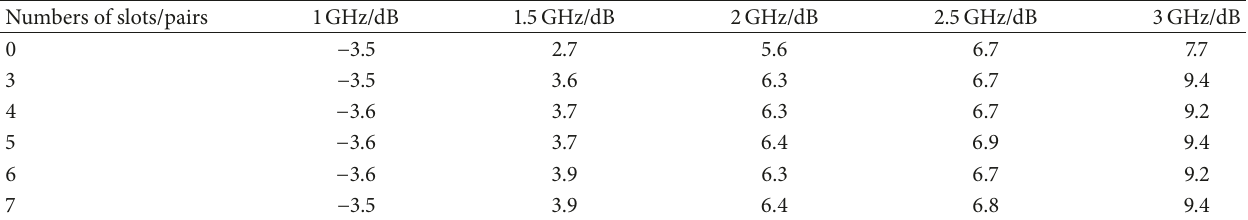
Table 2: Influence of different numbers of slots on gain in the 𝑦 direction at different frequencies.